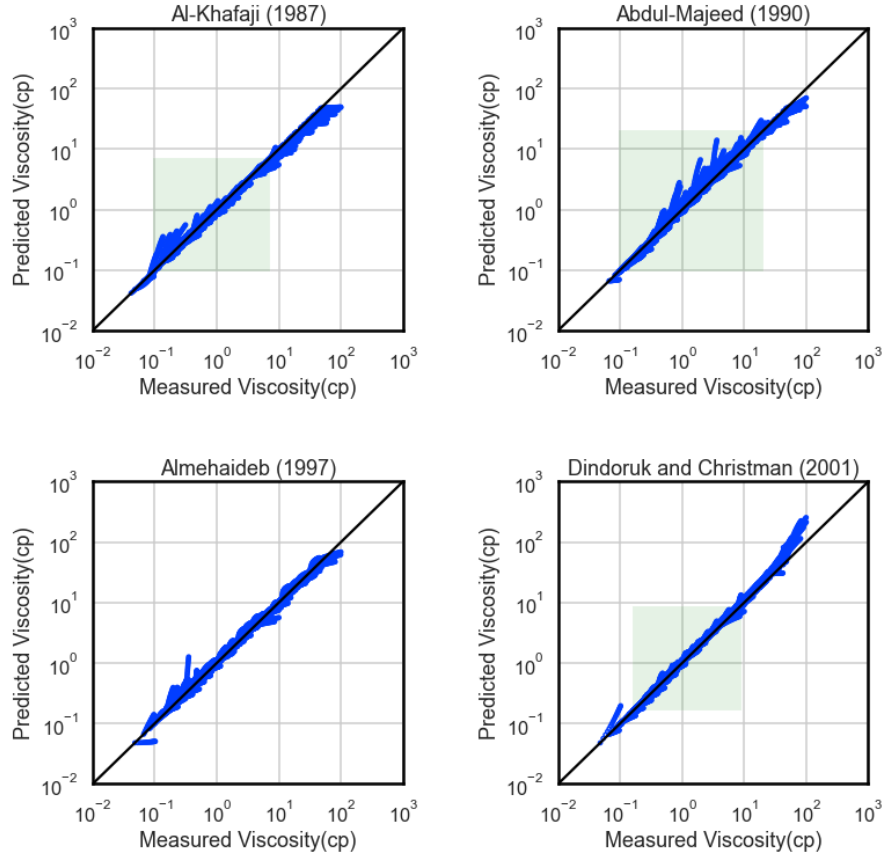
Figure A4. Parity plots of correlations in cluster B 2 . There seem to be some fluids in the µ ob range of (0.01–0.1) that are severely under- estimated by many of the models, even the best performing ones. On one hand, this can be attributed to the logarithmic scaling of the axes, which enhances relative errors in low values, but on the other, this range is not within the design area of any of the